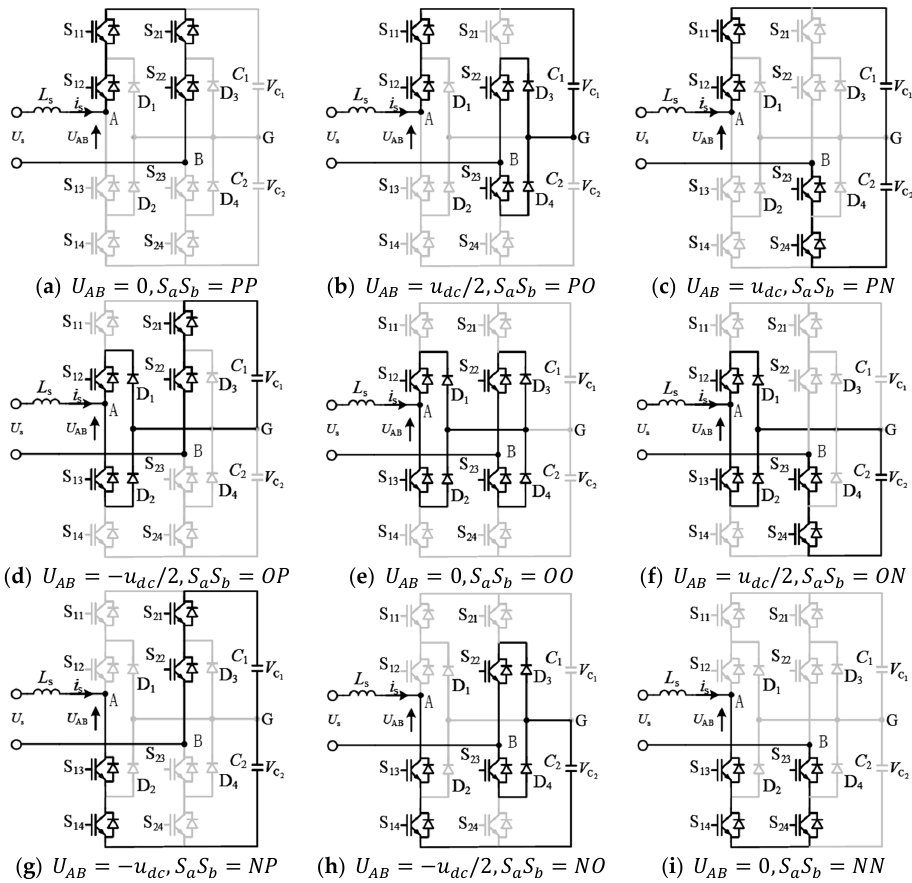
Figure 2. ( a – i )The nine switching states of the single-phase three-level rectifier. Figure 2. ( a – i ) The nine switching states of the single-phase three-level